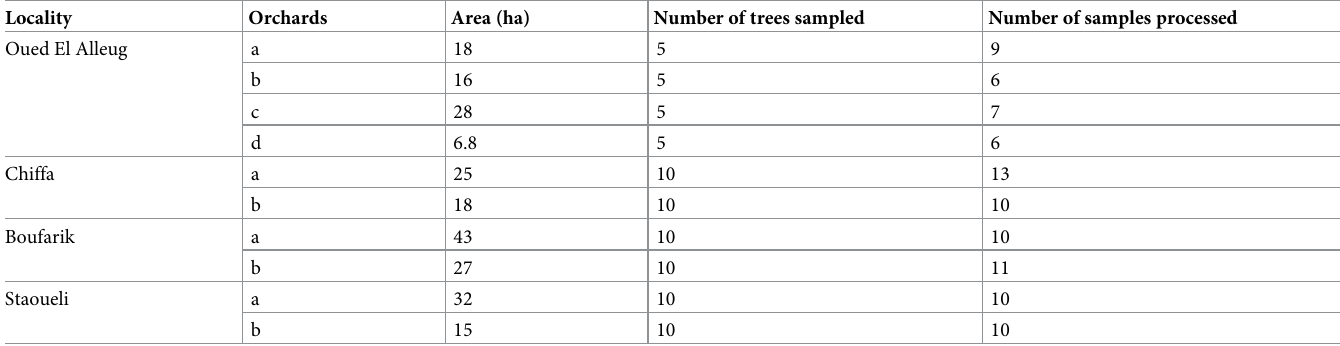
Table 1. Citrus orchards surveyed and number of samples